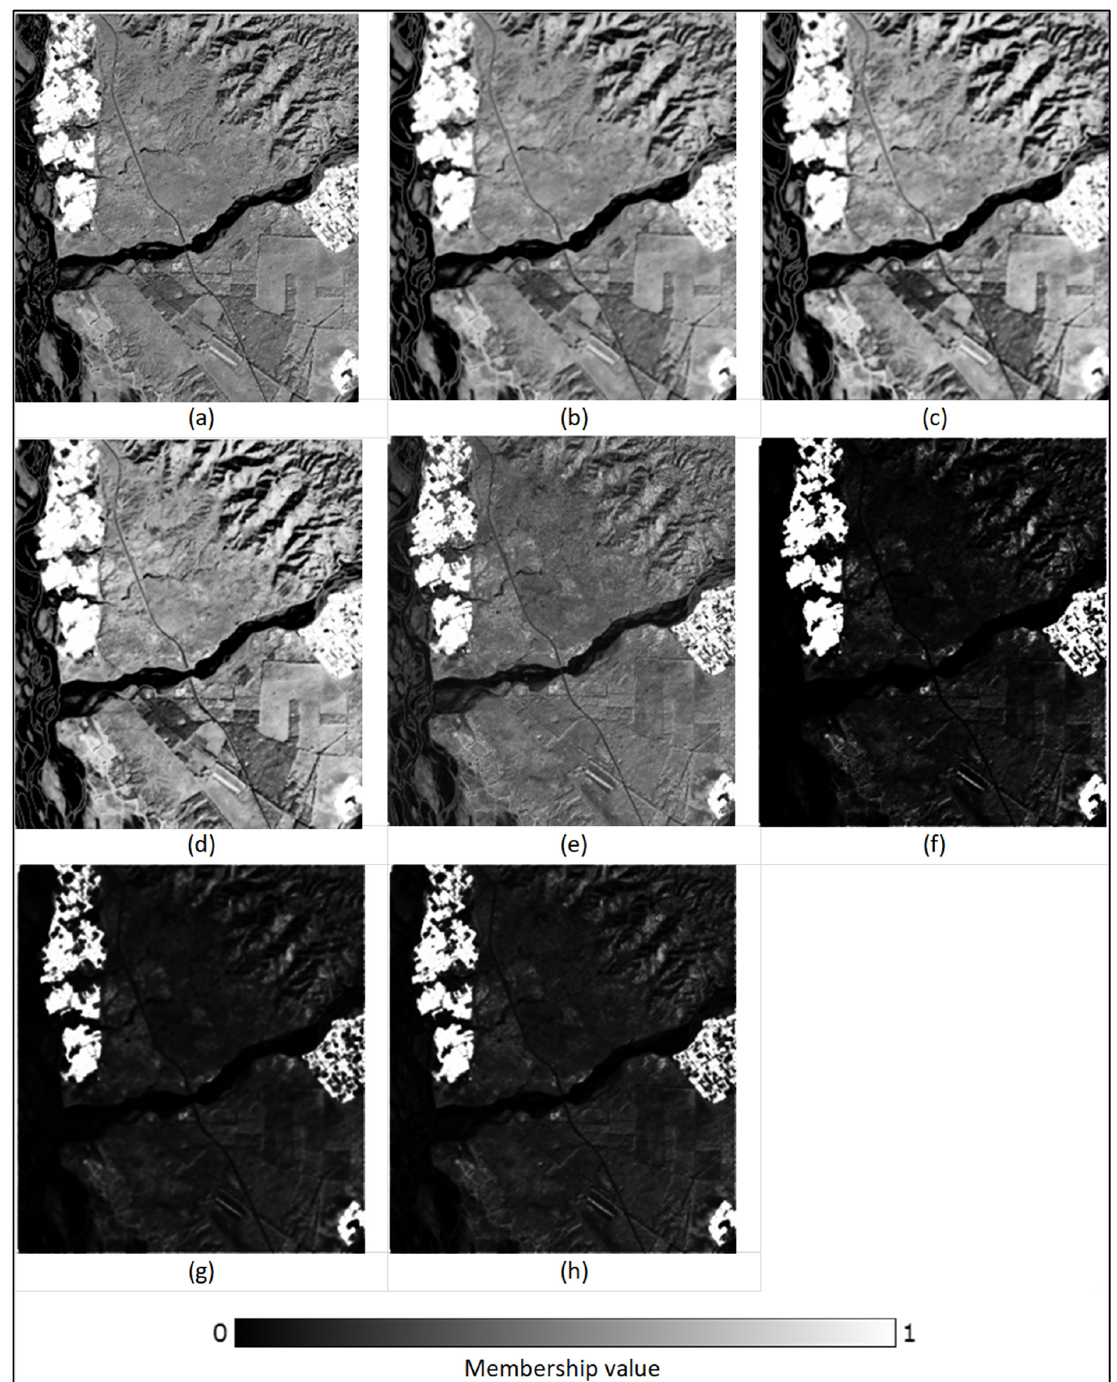
Figure 16. Membership fraction (0–1) for the class ‘Wheat’ generated by ( a ) FCM, ( b ) FCM-S, ( c ) FLICM, ( d ) ADFLICM, ( e ) PCM, ( f ) PCM-S, ( g ) PLICM, and ( h ) ADPLICM classifiers in the presence of untrained classes.